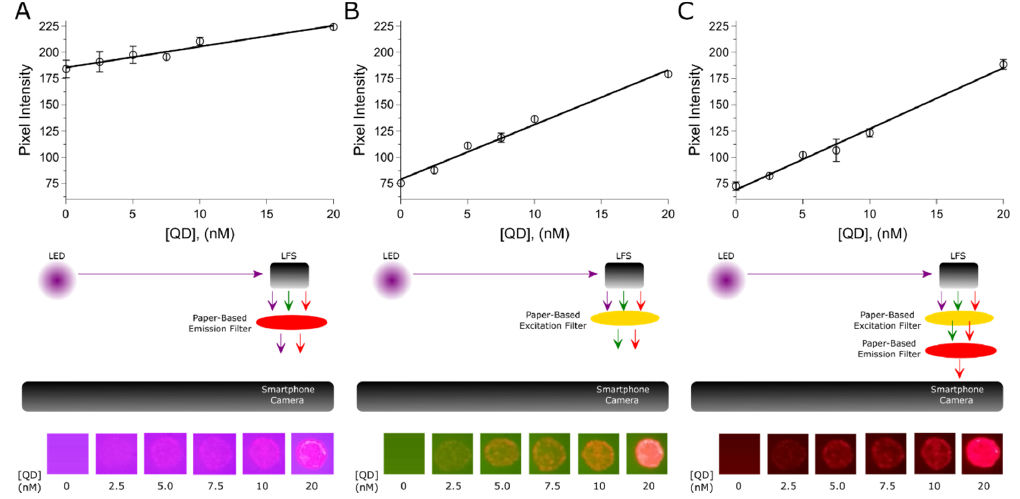
Figure 3. The resulting calibration plots under different paper-based filter configurations and the corresponding images. ( A ). Red filter. ( B ). Yellow filter. ( C ). Red + yellow filter. The error bars represent the standard deviation of two QD spots drop-casted onto lateral flow strips (LFS). The size of the spots is c.a. 3 mm.